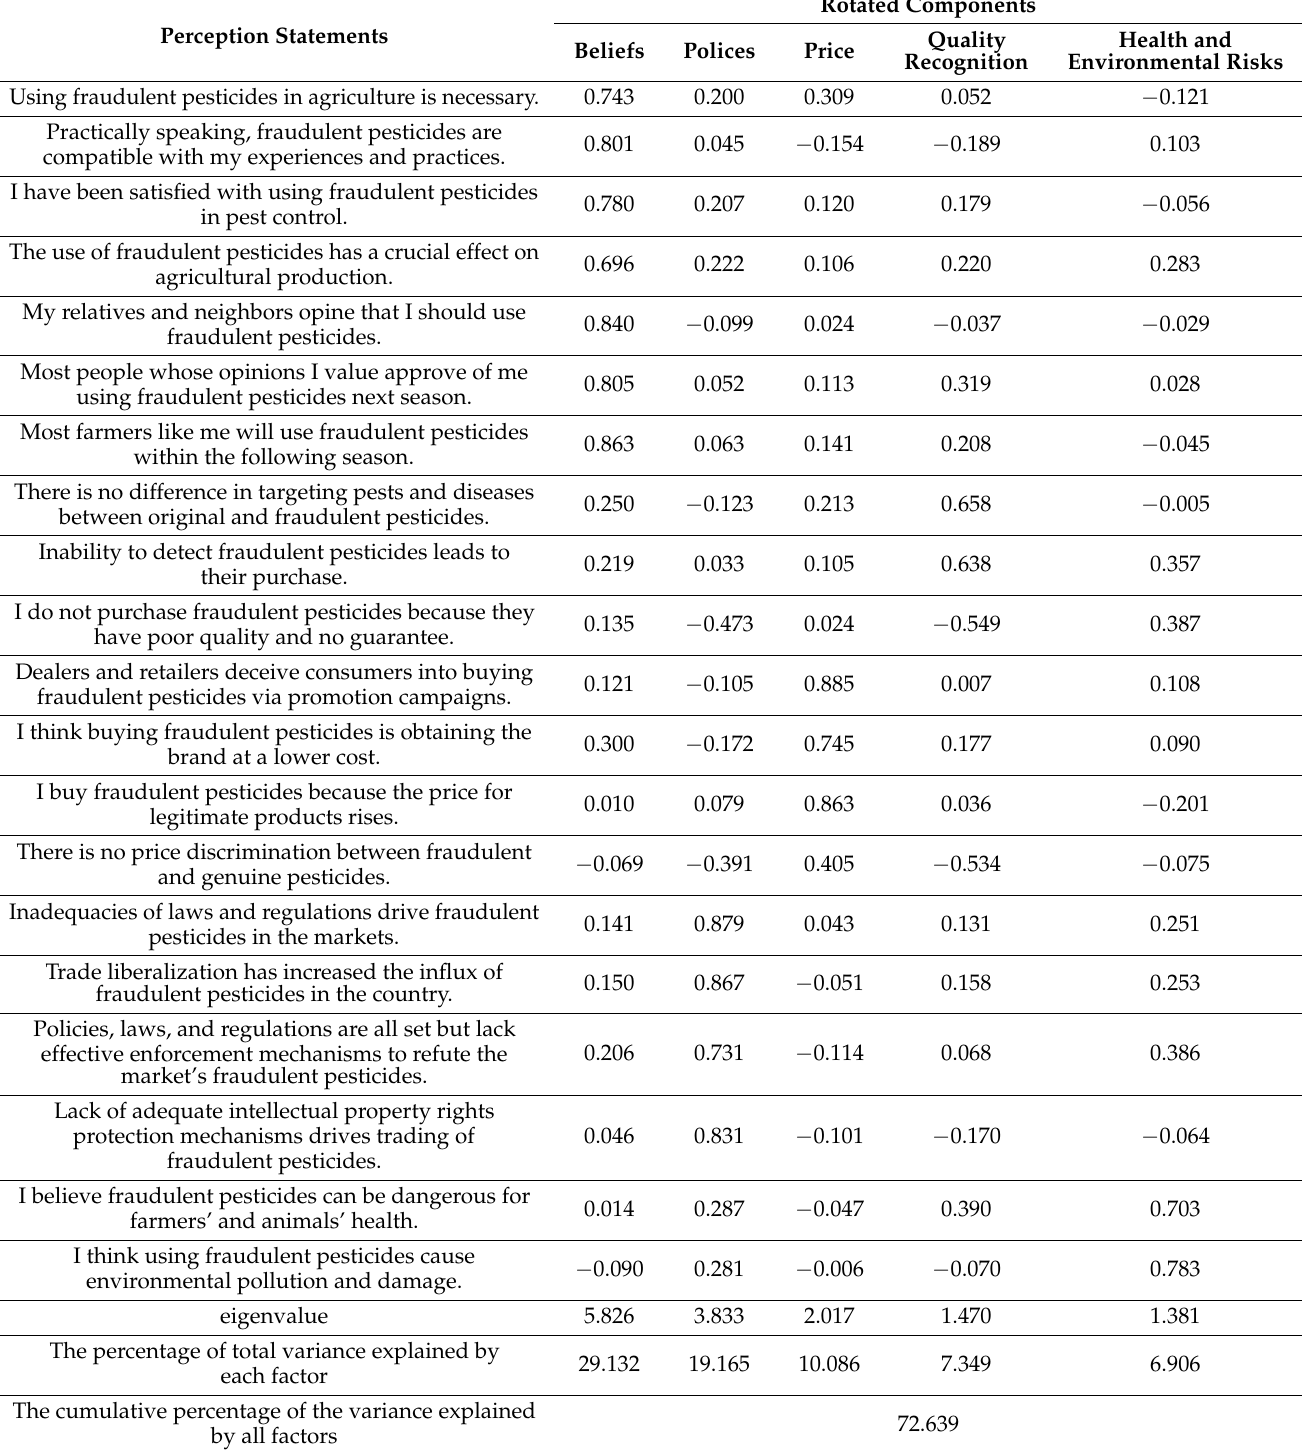
Table 3. Factor analysis of marketability of fraudulent pesticide variables using varimax